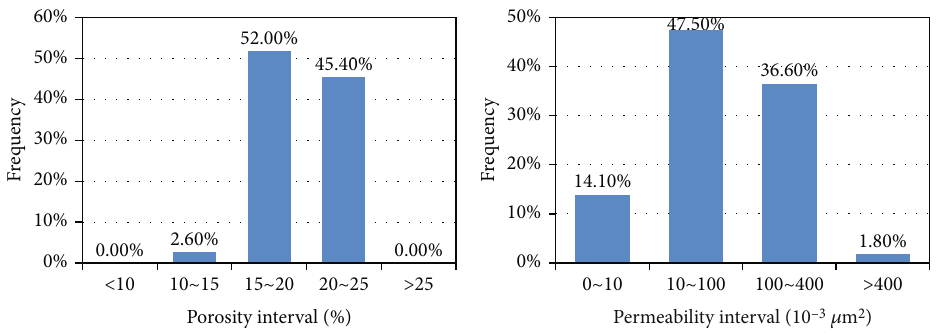
Figure 9: Distribution of porosity and